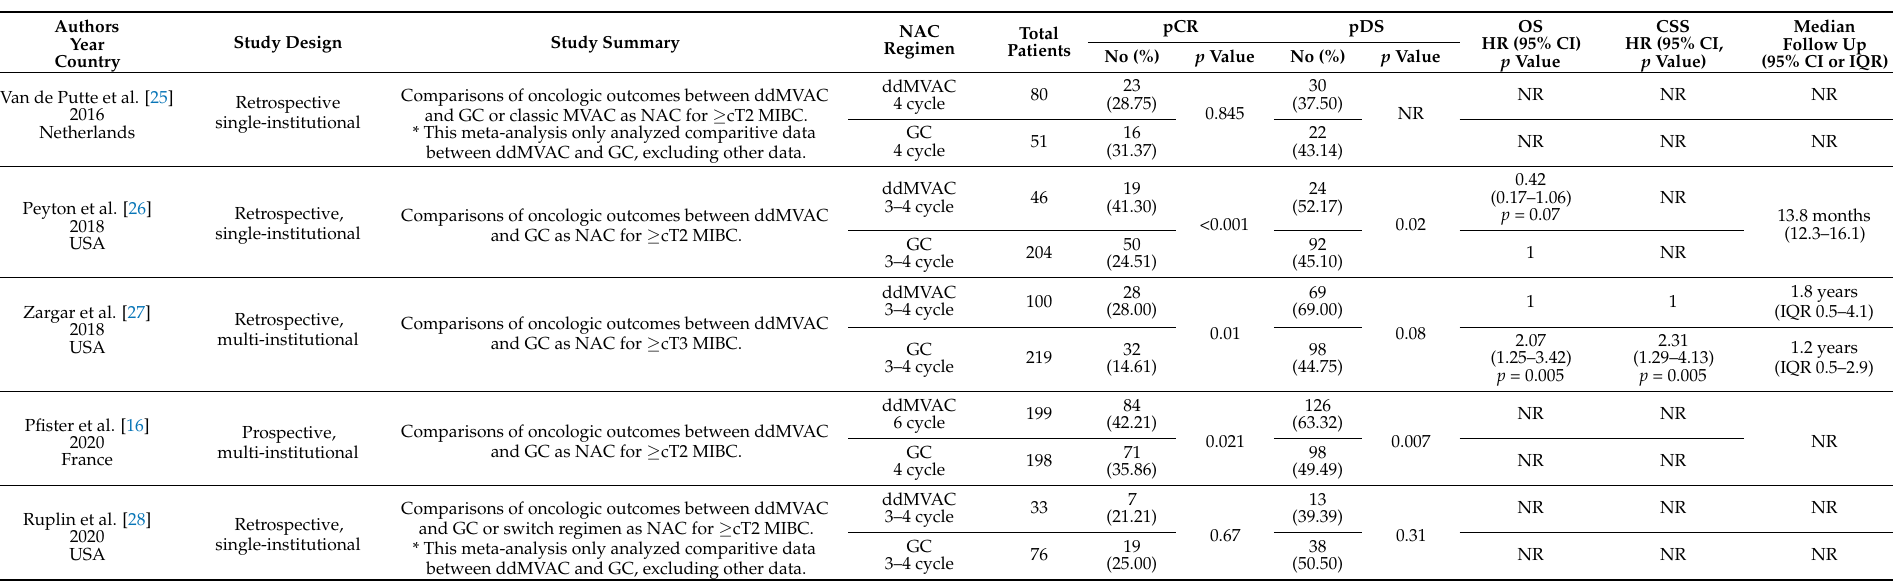
Table 1. Characteristics of the eligible